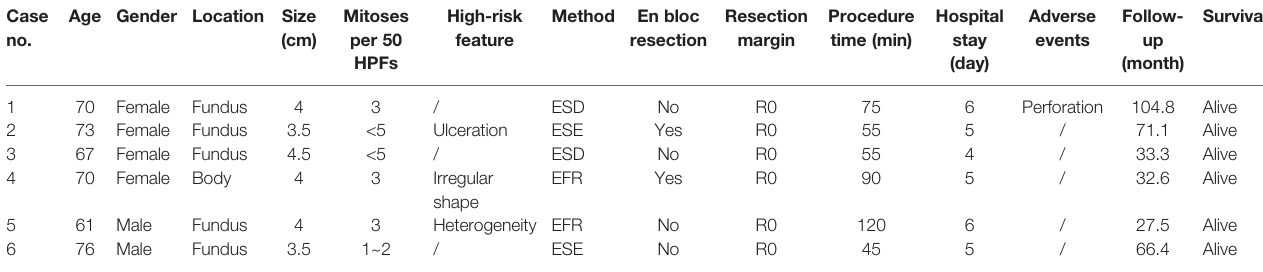
TABLE 3 | Clinical characteristics of patients with tumours larger than 3.5 cm and undergoing endoscopic resection. Case no.